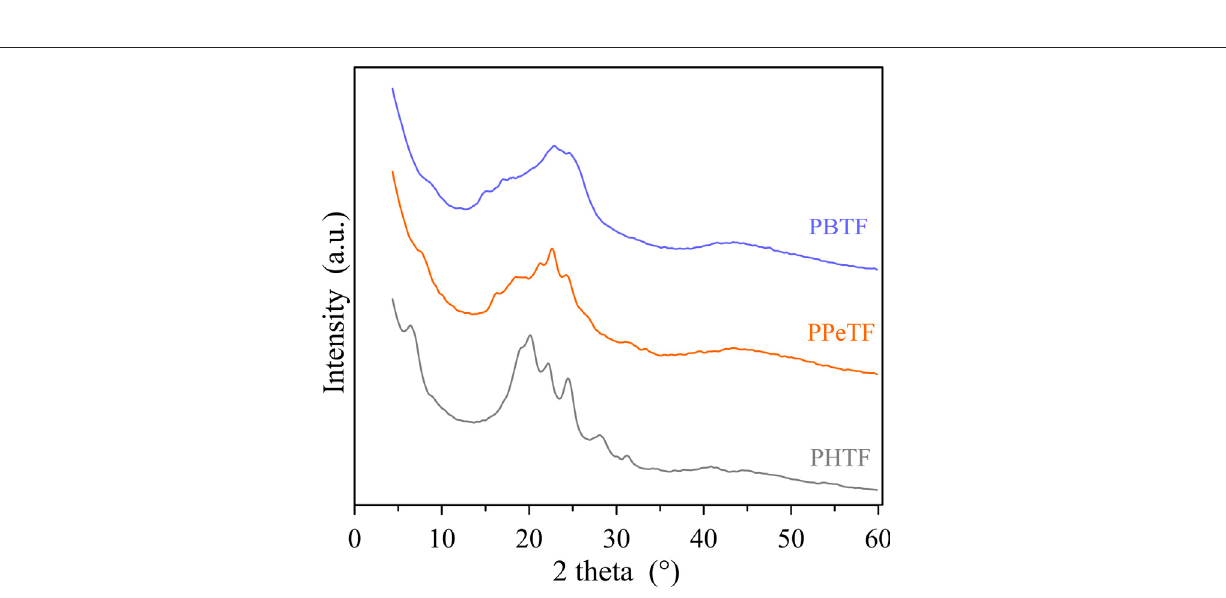
Frontiers in Chemistry |